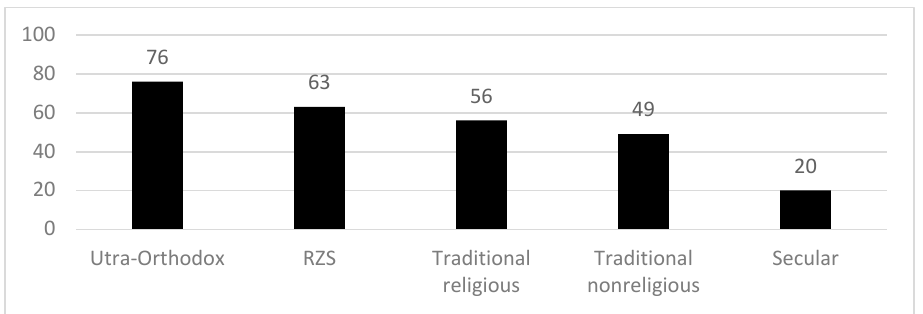
Figure 9. Consider the Jewish–Arab tension as the strongest of all national tensions, by level of religiosity (%). (Source: Israeli Democracy Index, 2021).